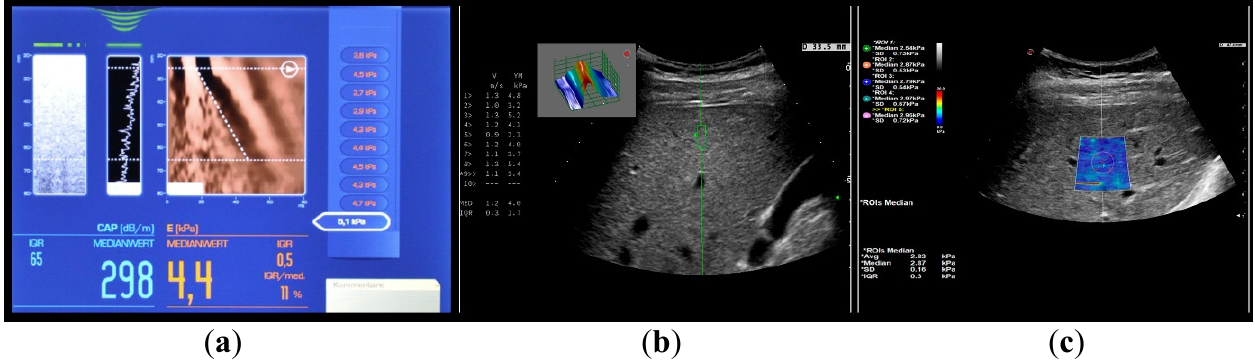
Figure 2. US based elastographic techniques. ( a ) transient elastography; ( b ) point shear wave elastography; ( c ) 2D shear wave elastography.